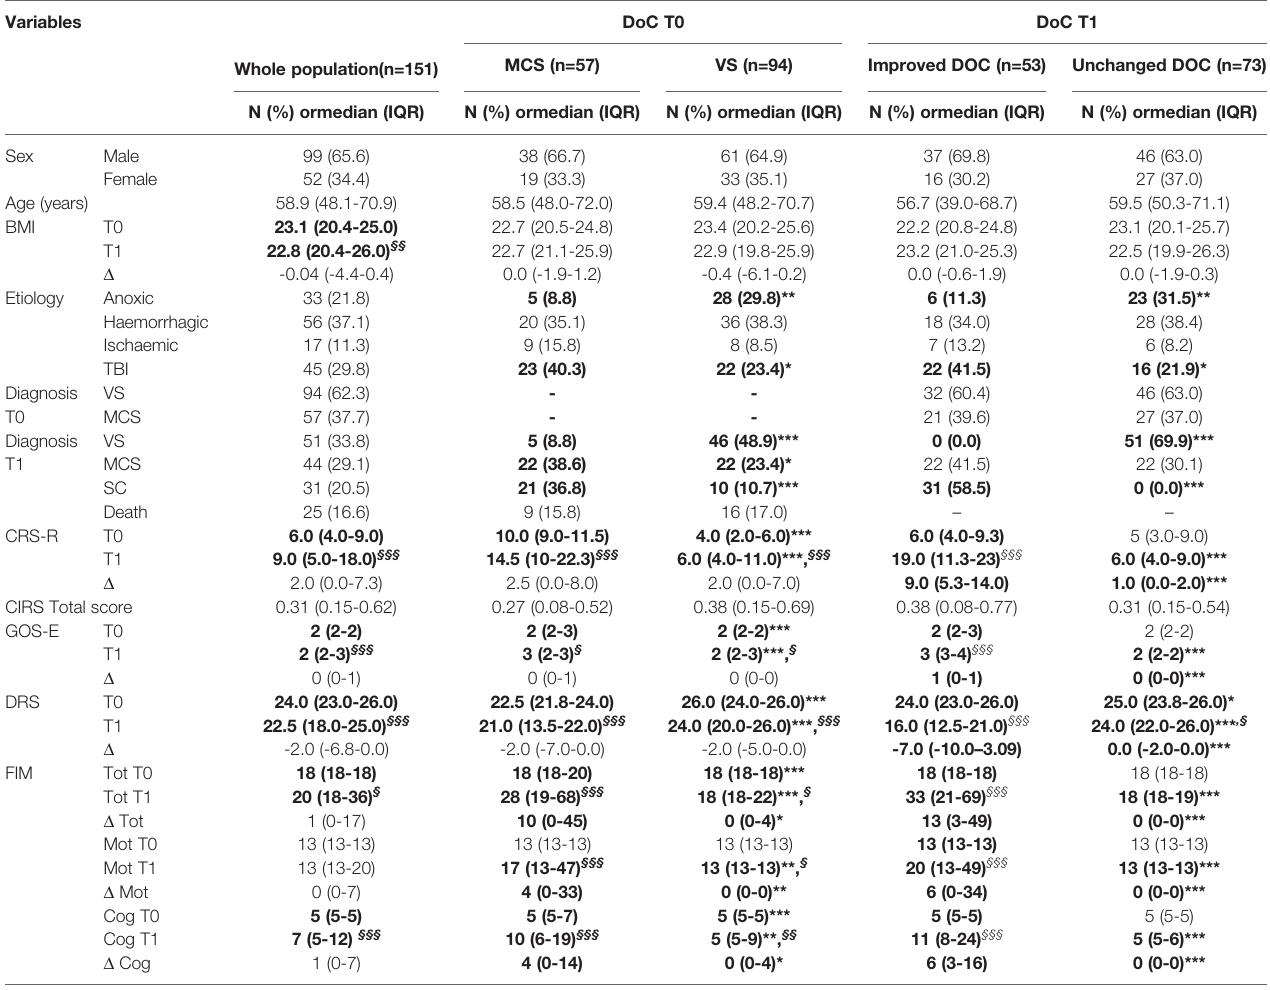
TABLE 1 | Clinical and functional characteristics of the study population on admission (T0) and at discharge (T1) as a whole and after subgrouping according to the diagnosis of DoC on admission (MCS vs VS) and the change in DoC after 6-months neurorehabilitation program (improved DoC vs unchanged DoC). Variables Whole